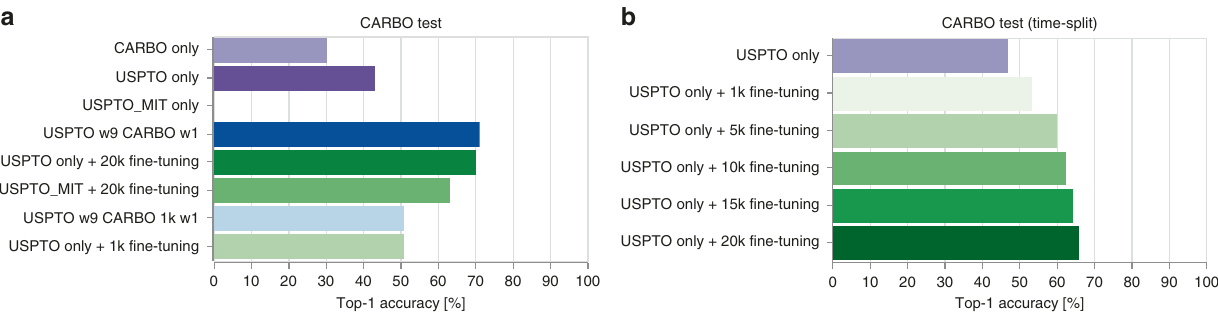
Fig. 3 Fine-tuning scenario results. a CARBO random split test set performance for different training strategies. In green are the top-1 accuracies of the models that were fi ne-tuned on either 1k or 20k CARBO reactions shown. For comparison, we included in purple the top-1 accuracies of the models trained on the single data sets (CARBO, USPTO, and USPTO_MIT). Blue are the performances of models trained in the multitask scenario. b CARBO time split test set performance for different fi ne-tuning set sizes. Source data are provided as a Source Data fi